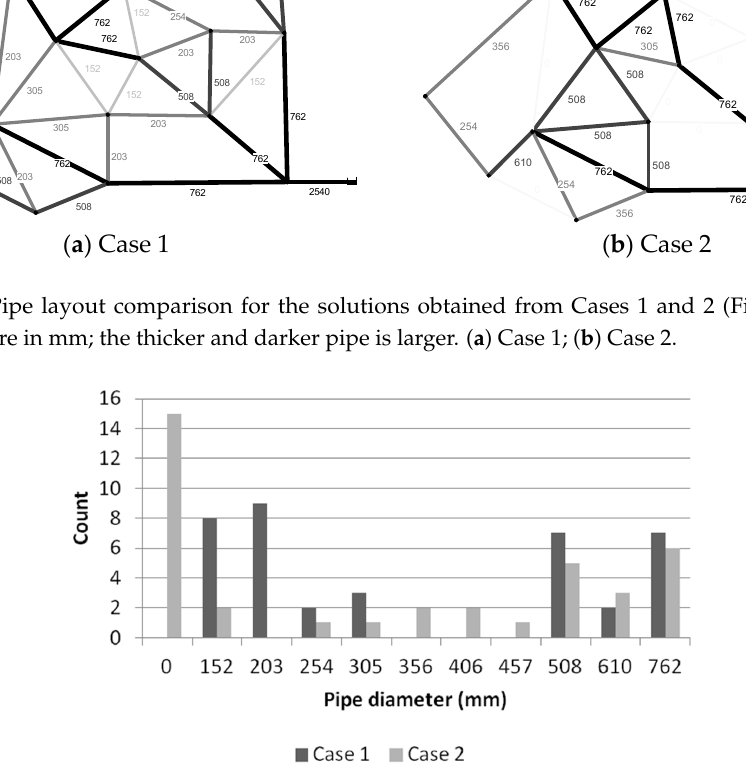
Figure 6. Histogram of pipes by the pipe diameter.